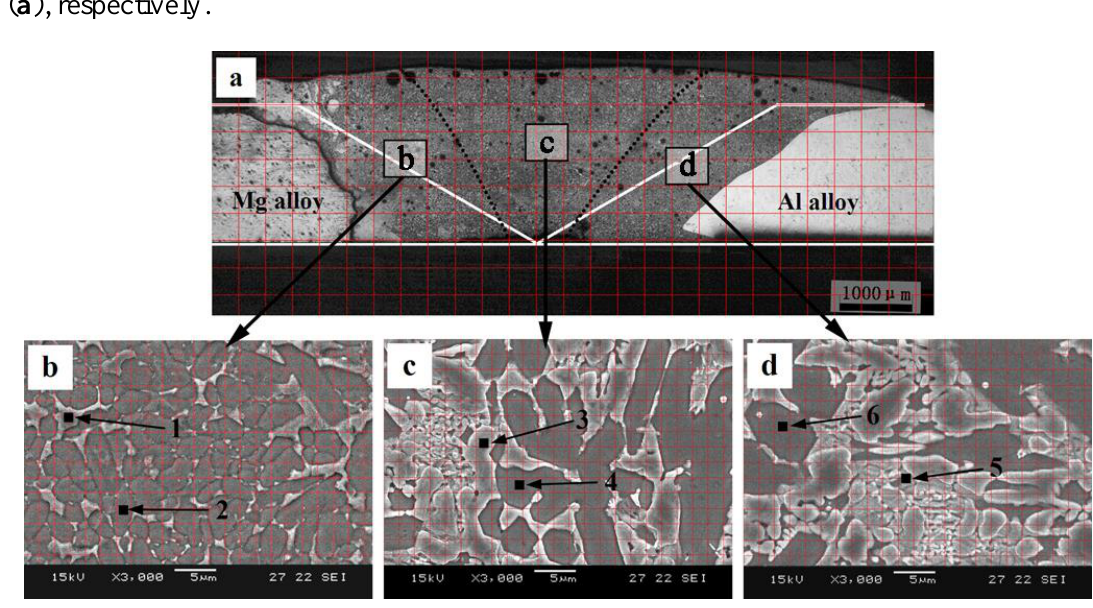
Figure 3. Microstructures of welded joint filling with pure Zn filler metal. ( a ) The macrostructure of the joint; ( b ), ( c ) and ( d ) the magnified images of ( b ), ( c ) and ( d ) in ( a ), respectively.